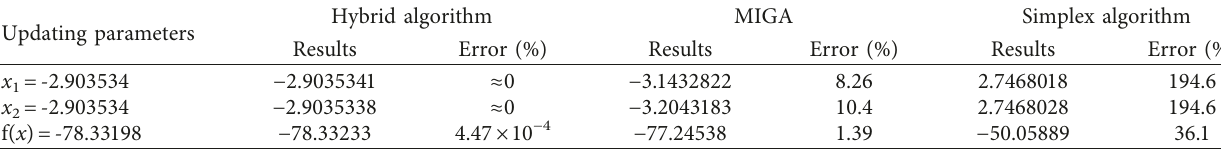
Table 2: The results of the hybrid algorithm.